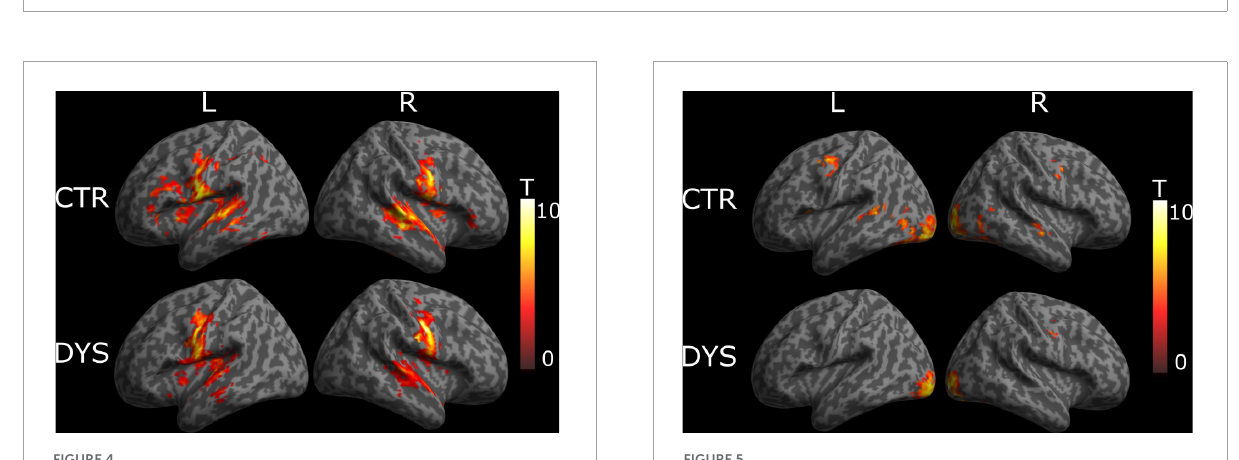
FIGURE4 Univariate whole-brain results of the Lexicality effect (words minus hash marks). Statistical t-maps for dyslexic readers (DYS, n = 20) and controls (CTR, n = 20) are projected on left (L) and right (R) cortical surfaces (from MNI standard human cortex) using an uncorrected voxel-wise threshold of p < 0.001 and a cluster-wise threshold with FDR correction of q < 0.05.